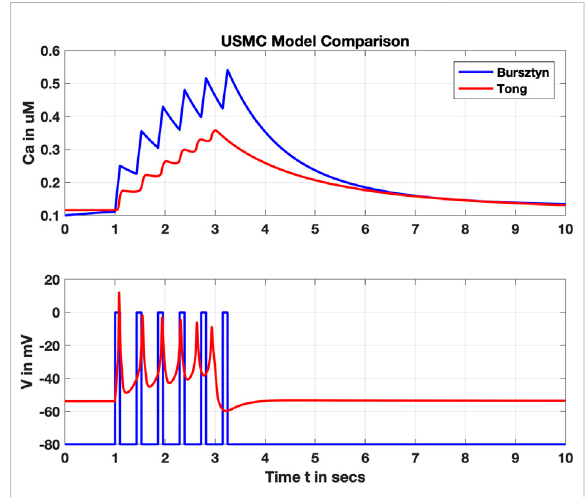
FIGURE 5 Comparison of the Bursztyn et al. and Tong et al. uSMC models. Shown are simulated intracellular calcium (Ca, upper panel) and membrane voltage (V, lower panel). V is an input parameter for the Bursztyn, whereas V is an output variable for the Tong responding to a steady stimulus current. Resulting Ca 2+ concentrations are roughly comparable but with the simpler Bursztyn model rising higher likely due to lack of other currents such as the potassium suites included with the Tong